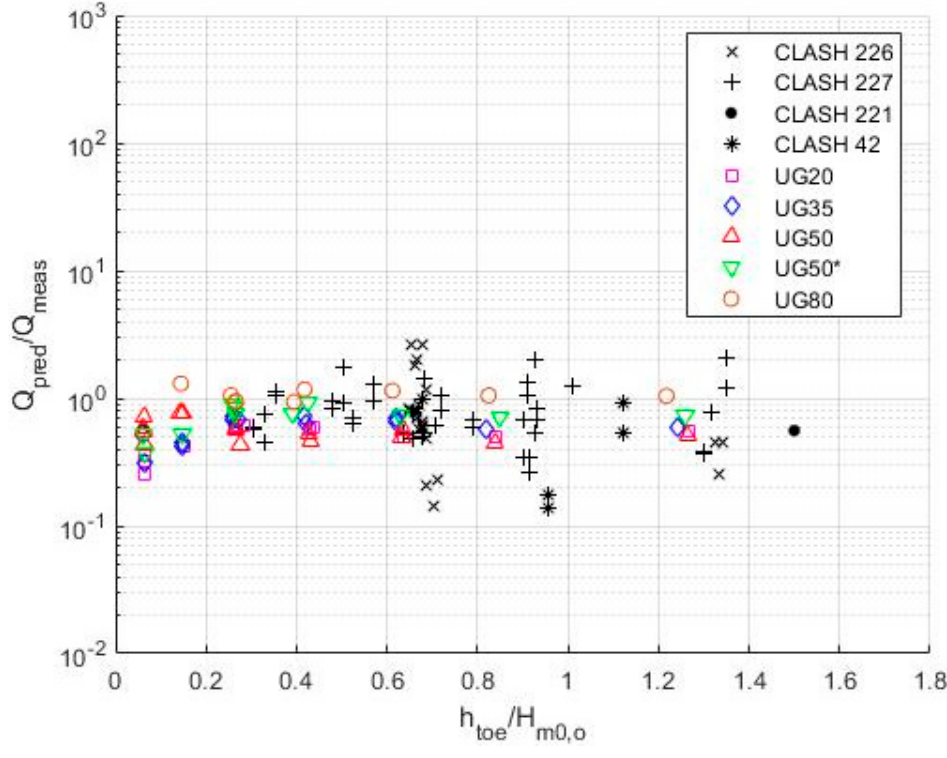
Figure 12. Ratio of dimensionless predicted (Van Gent [12] with equivalent slope approach) to measured overtopping discharge versus the relative water depth.